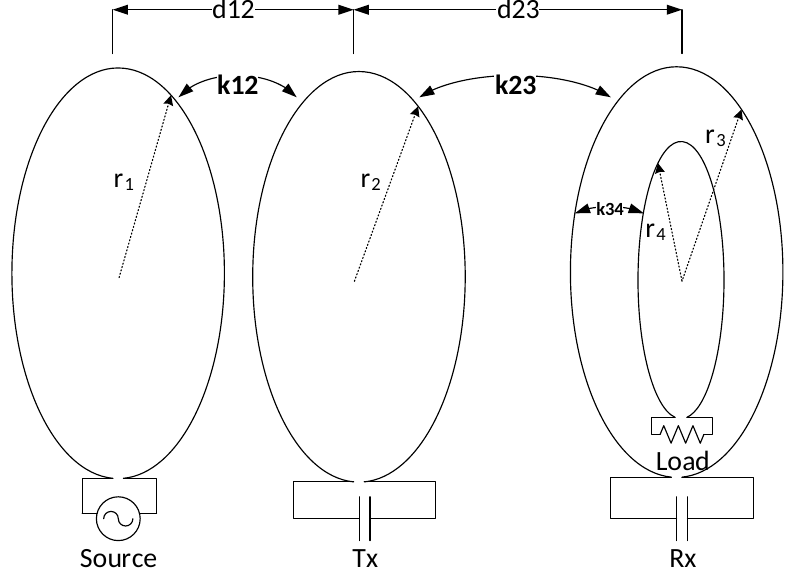
Figure 1. Combined SCMR-CSCMR